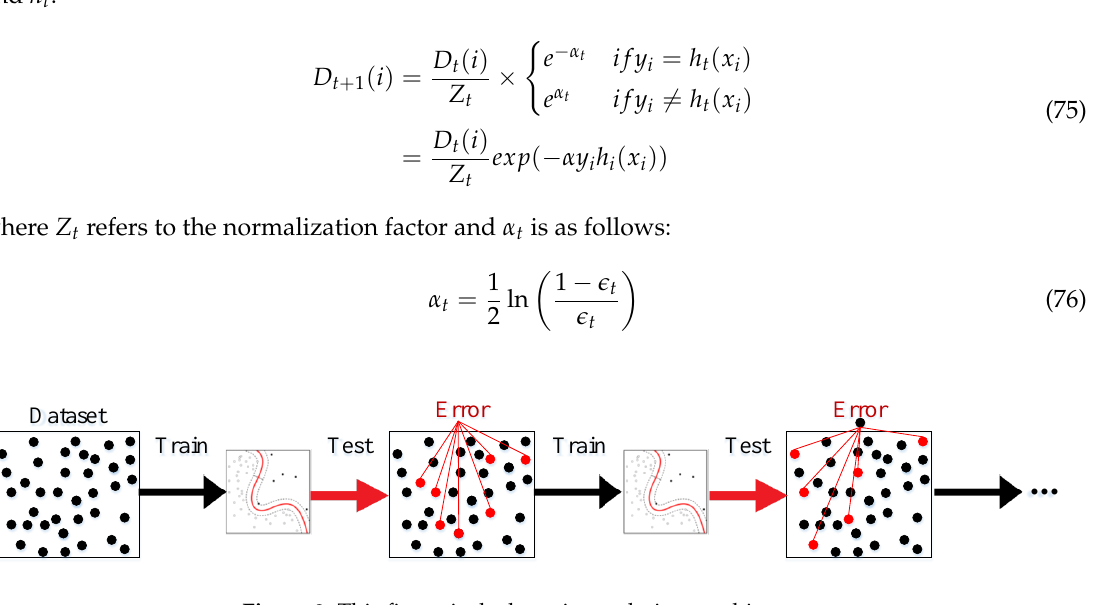
Figure 9. This figure is the boosting technique architecture.